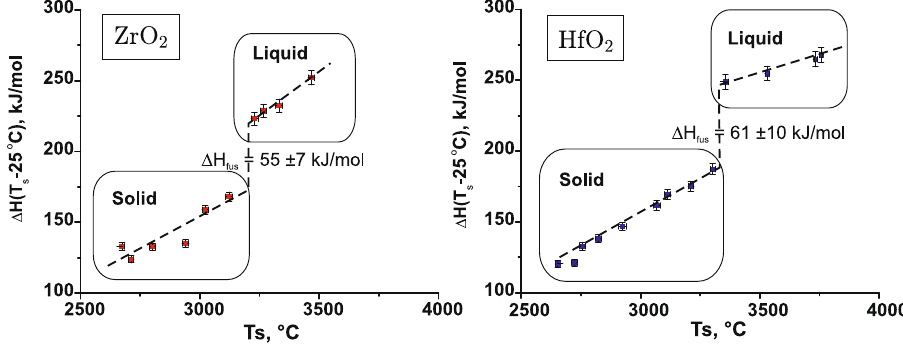
Figure 4. Fusion enthalpy from drop and catch calorimetry on ZrO 2 and HfO 2 in argon flow. T s – surface temperature before the drop measured by